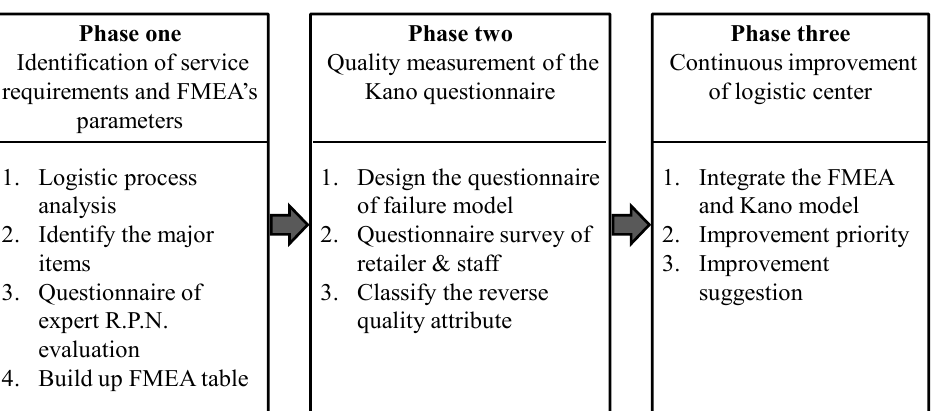
Figure 1. Research process.